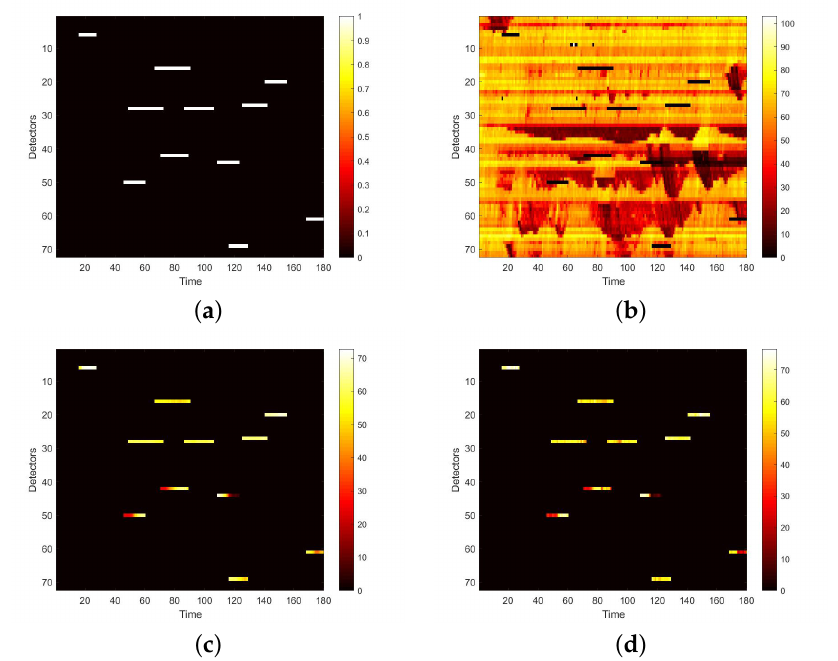
Figure 13. Speed matrices of Neihuan elevated highway (the 23rd day of testset) with strip damage visualized as heat maps. ( a ) Mask matrix visualized as a heat map. ( b ) Damaged speed matrix visualized as a heat map. ( c ) Repaired speed matrix visualized as a heat map. ( d ) Real speed matrix visualized as a heat